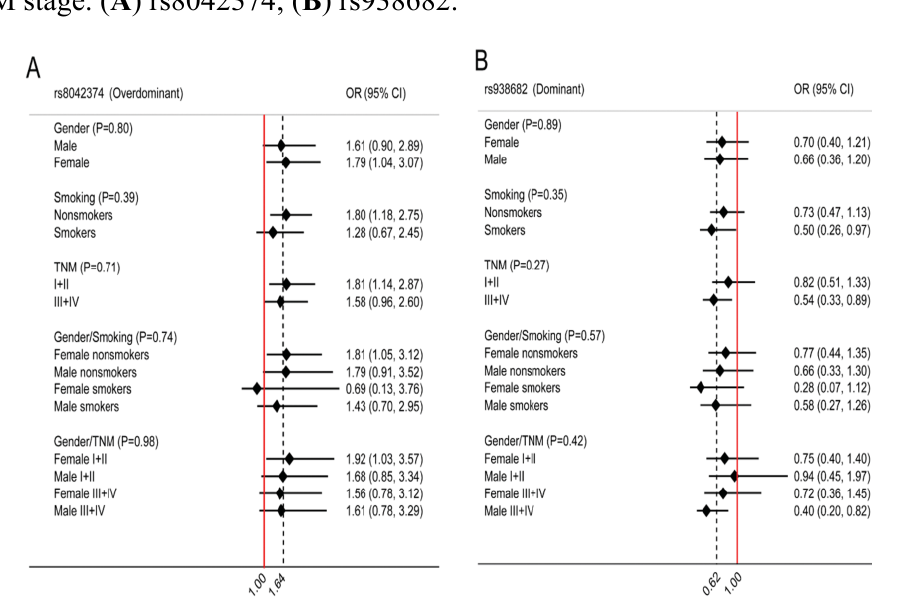
Figure 1. Association of lung ADC risk with two SNPs stratified by gender, smoking status, and TNM stage. ( A ) rs8042374; ( B )